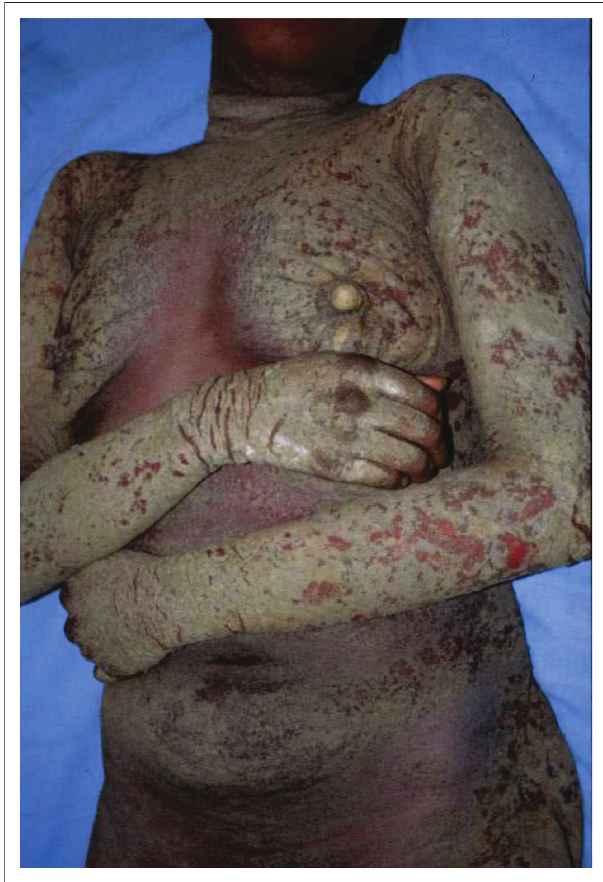
FIGURE 5: Crusted scabies in an immunocompromised patient.